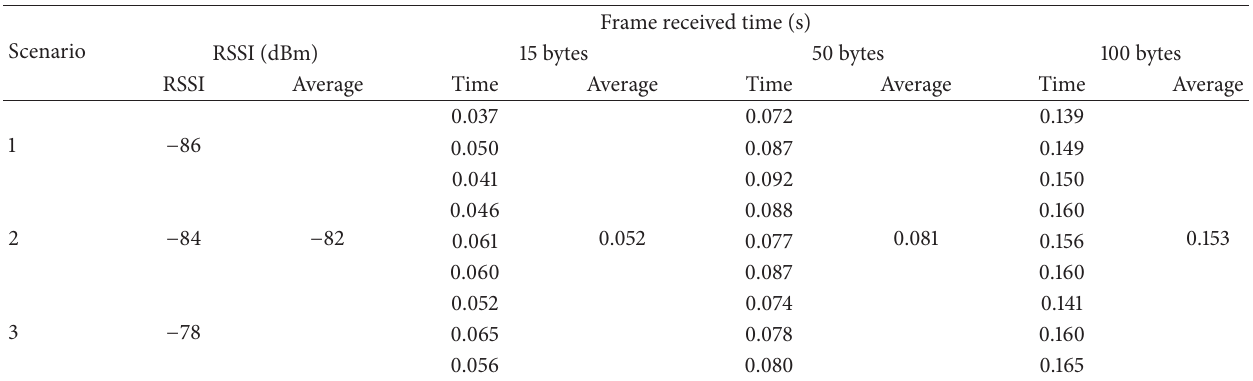
Table 6: Experimental results of Case 3 .